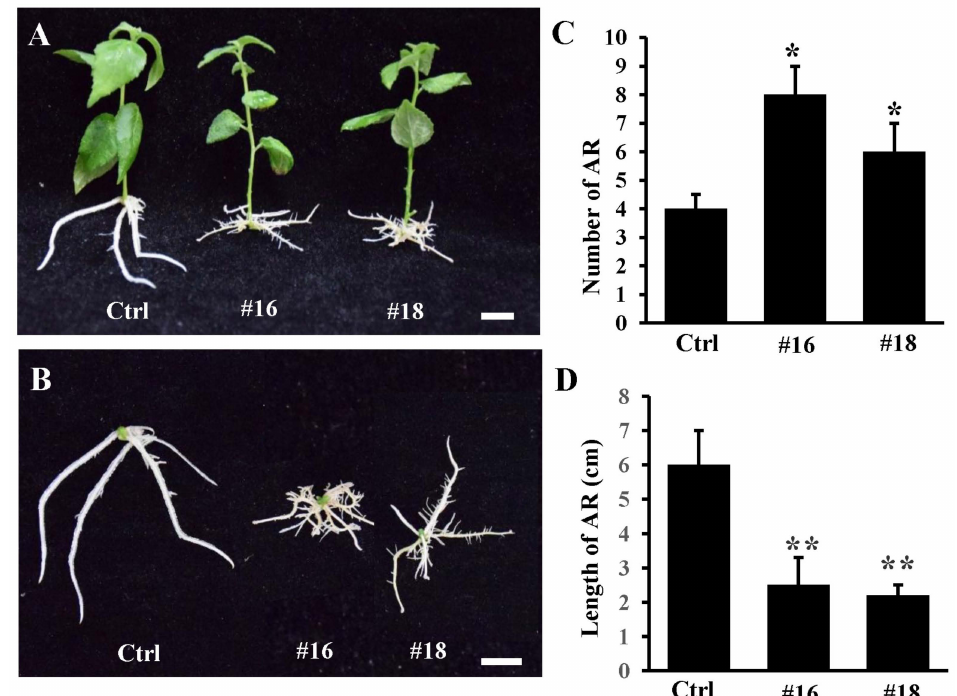
Figure 6. Overexpression of PtoWUSa promoted AR formation and inhibited its elongation in poplar. ( A , B ) Comparison of three-week-old Ctrl and PtoWUSa -overexpressing poplar plants including two independent transgenic lines #16 and #18. ( C , D ) Comparison of AR number ( C ) and AR length ( D ) between Ctrl and transgenic plants. * and ** indicated the di ff erence between Ctrl and each transgenic line at p < 0.05 and p < 0.01 levels, respectively. Scale bar: 1